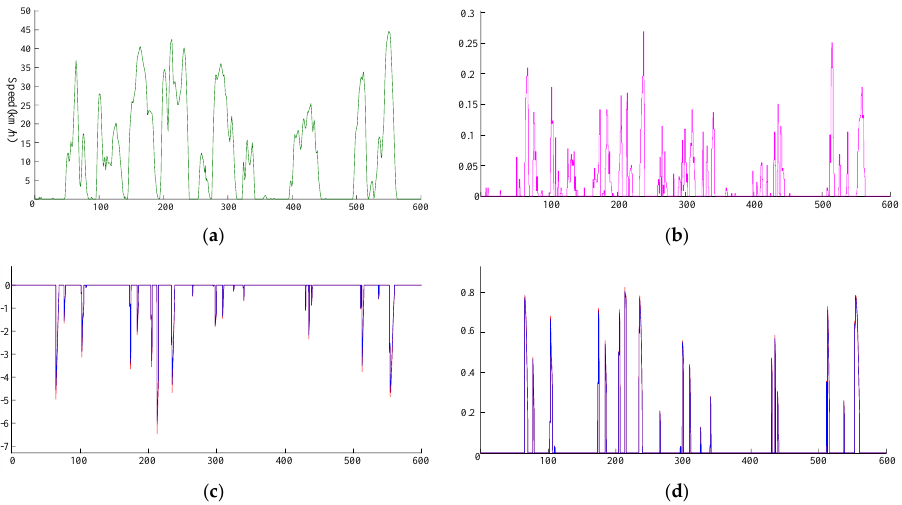
Figure 16. NYCC simulation results. ( a ) Vehicle speed; ( b ) Braking strength; ( c ) Front motor power; ( d ) Front regenerative braking system efficiency.